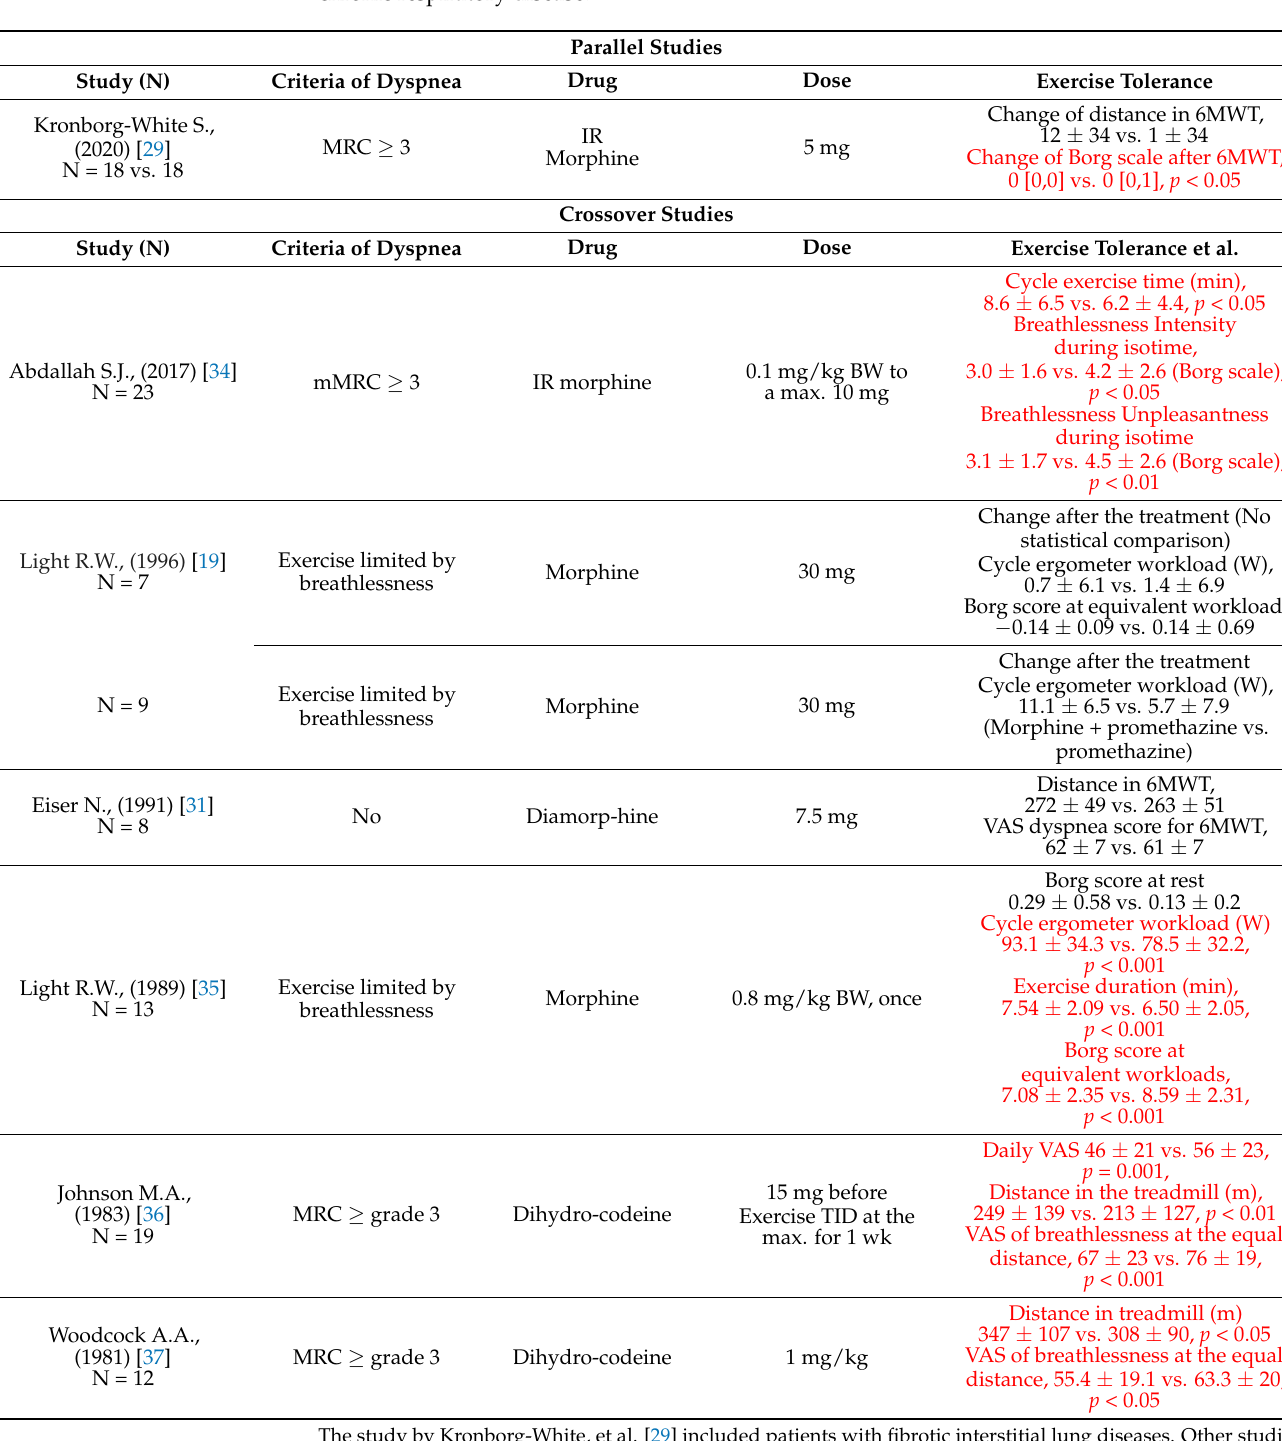
Table 3. Randomized controlled studies regarding acute effects of systemic opioids for non-cancer chronic respiratory